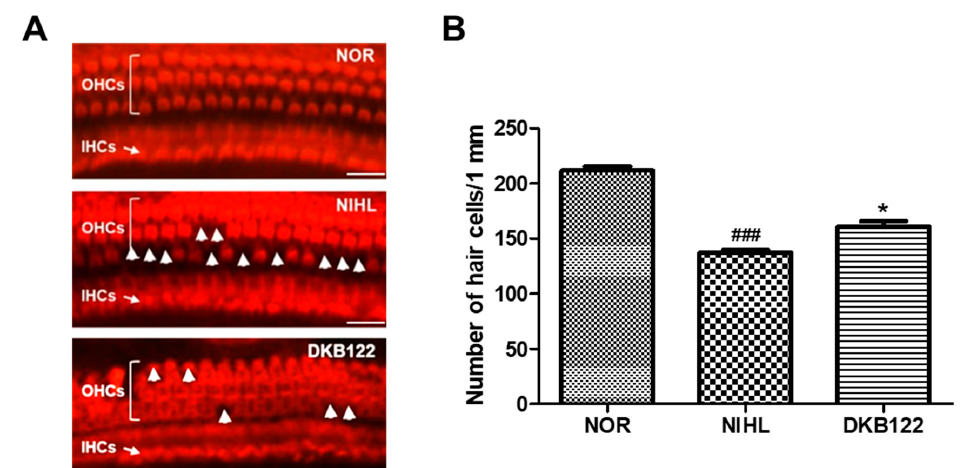
Figure 4. DKB122 alleviated noise-induced damage in cochlear hair cells. ( A ) Rhodamine phalloidin staining of the mid-apex section in the cochlea. Scale bar = 50 µm. ( B ) Number of OHCs in 1 mm ( n = 6). Data are presented as means ± SEM. * p < 0.05 (NIHL versus treated groups), ### p < 0.001 (normal group versus NIHL group).